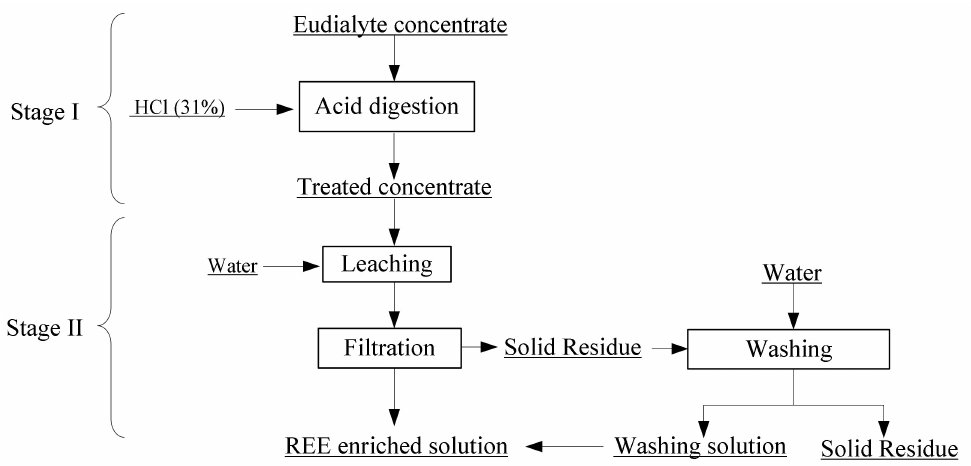
Figure 6. Proposed flowchart of the treatment of rare earth elements (REE) extraction from eudialyte concentrate.